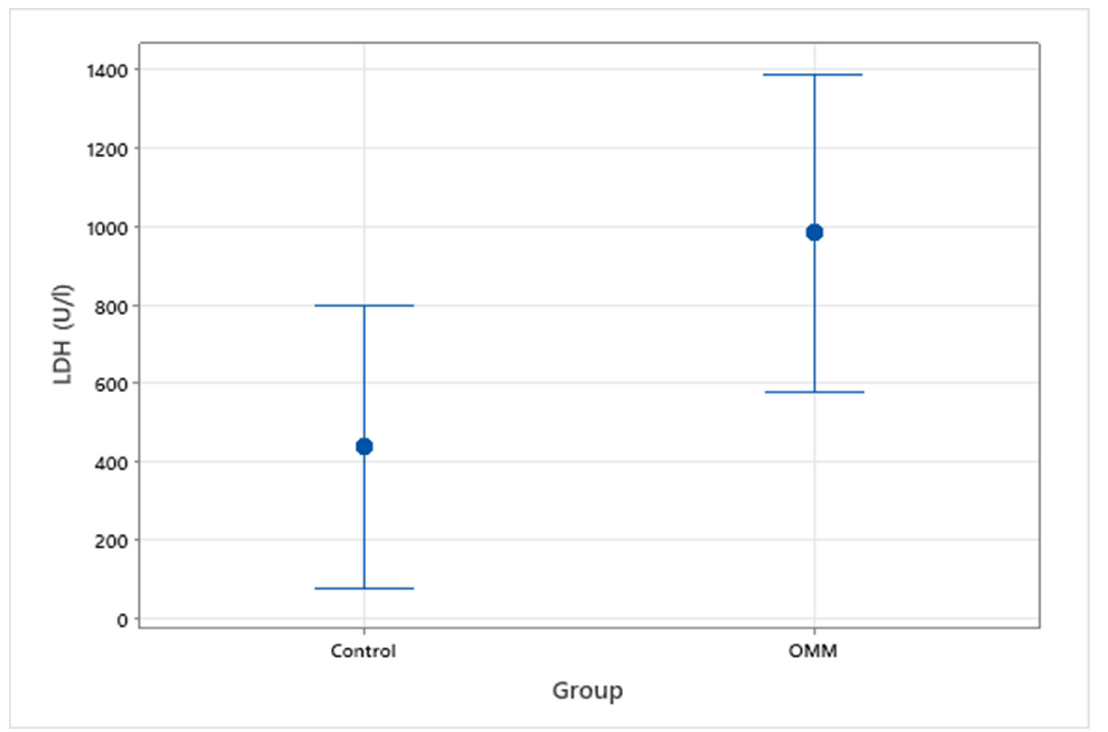
Figure 1. Interval plot to show serum LDH levels (U/L) in clinically healthy dogs vs. OMM patients.